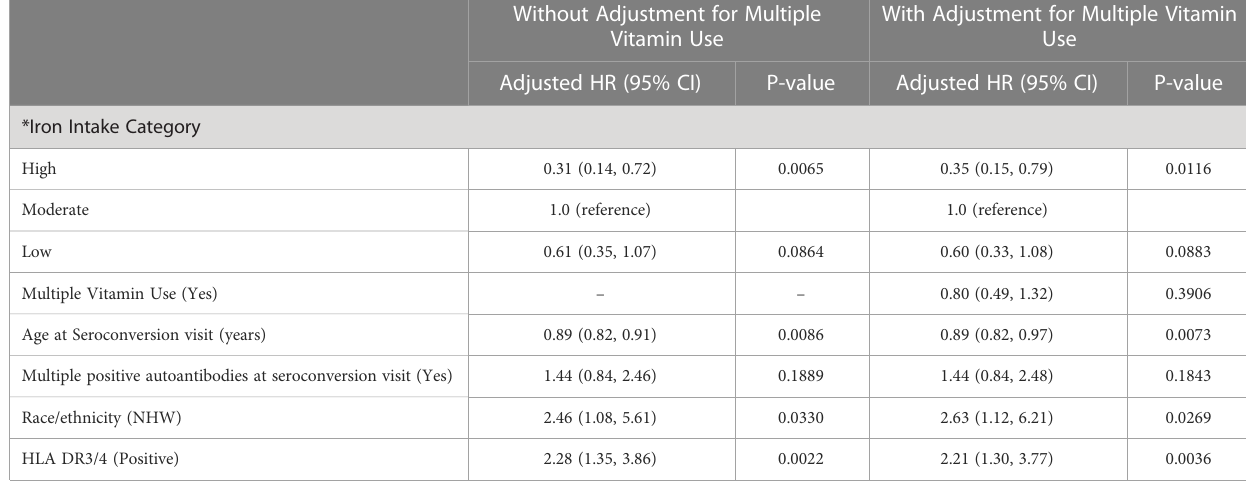
TABLE 2 Adjusted hazard ratios of iron intake categories and progression to T1D among 175 children with